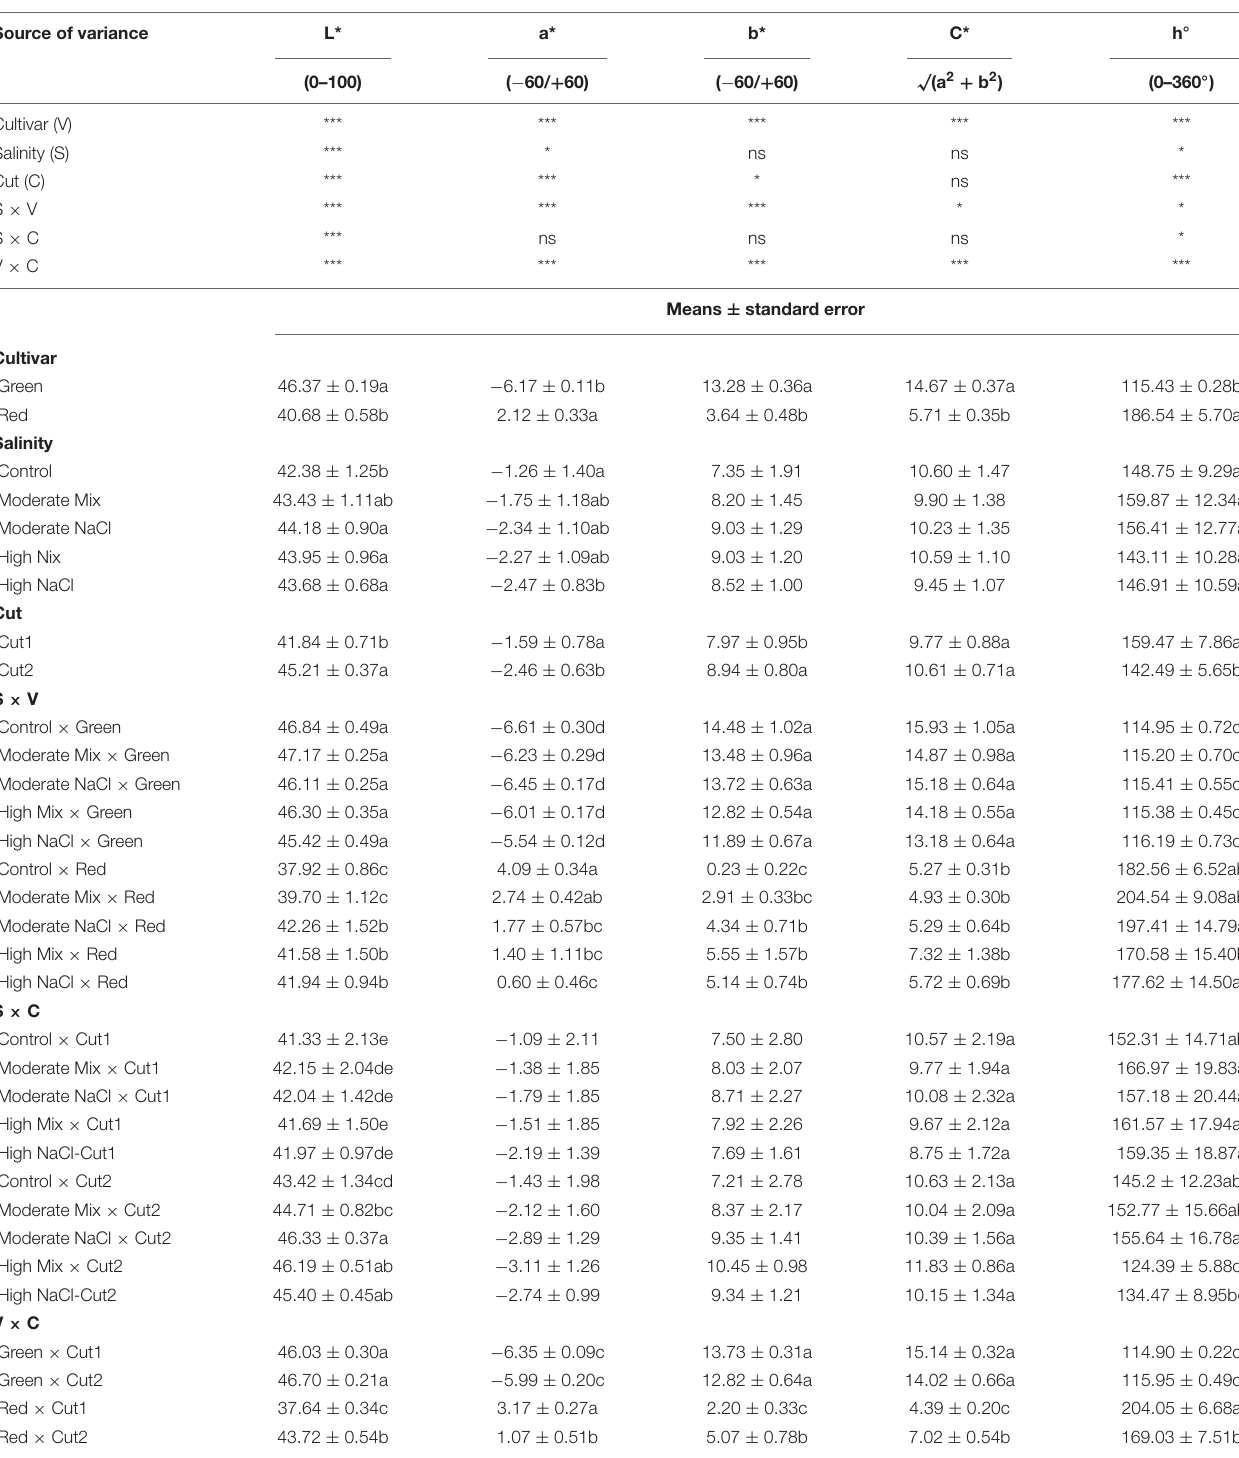
TABLE 3 | Analysis of variance (ANOVA) and mean comparisons for leaf colorimetric components L*, a*, b*, Chroma (C*), and hue Angle (h ◦ ) of the Green and Red cultivars grown hydroponically under iso-osmotic salinity treatments and harvested in two sequential cuts. Source of